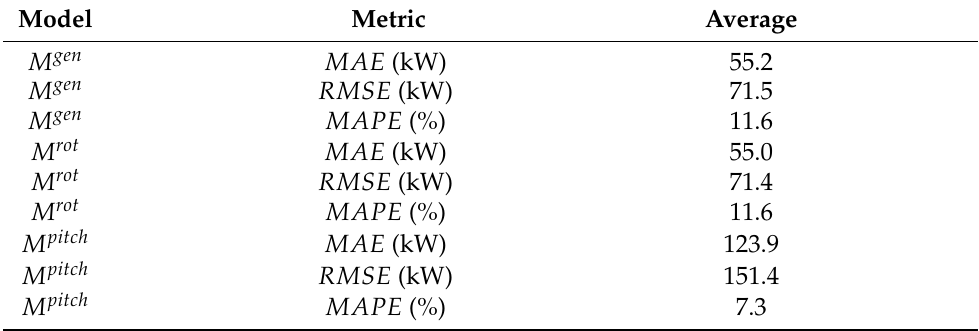
Table 7. Results of the multivariate PCR models validation (WF1): for brevity, the average wind farm results are reported.